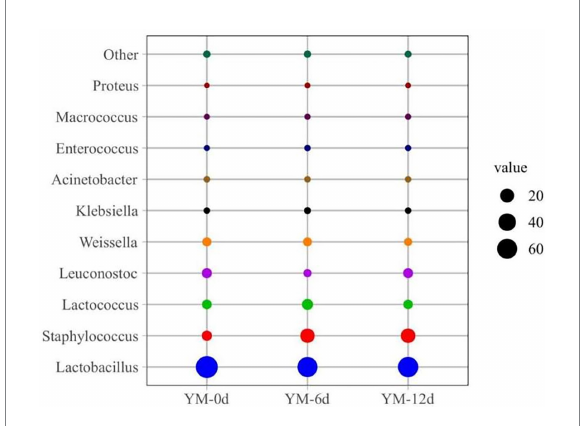
FIGURE 2 Relative abundance of bacteria community at genus levels in fermented sausage during ripening process.